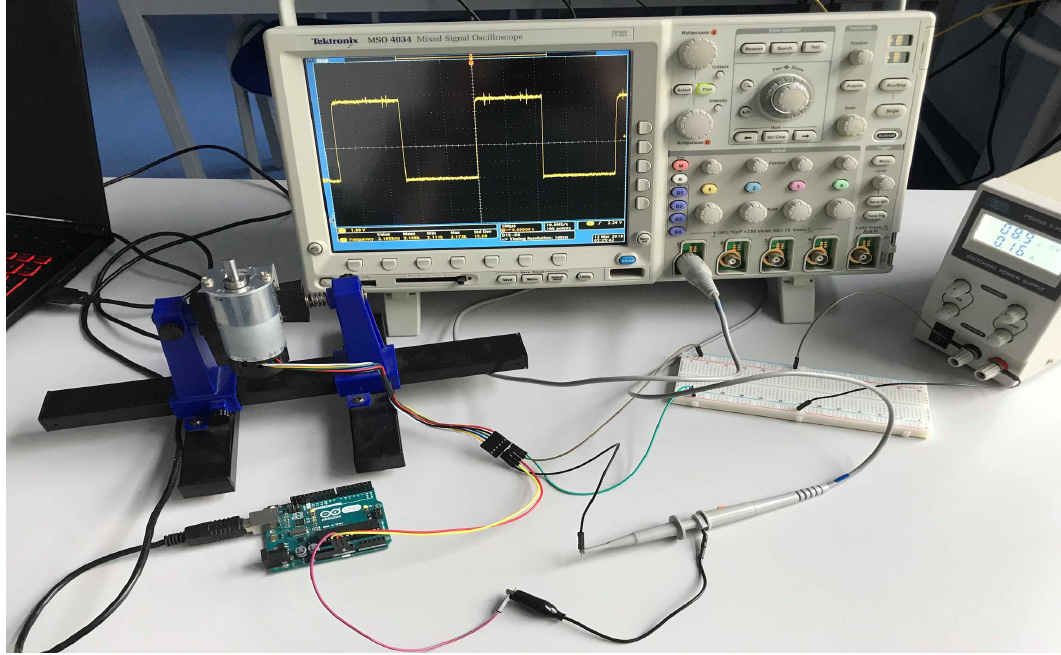
Figure 10. Measurement station with a geared DC motor and a Tektronix MSO 4034 oscilloscope.